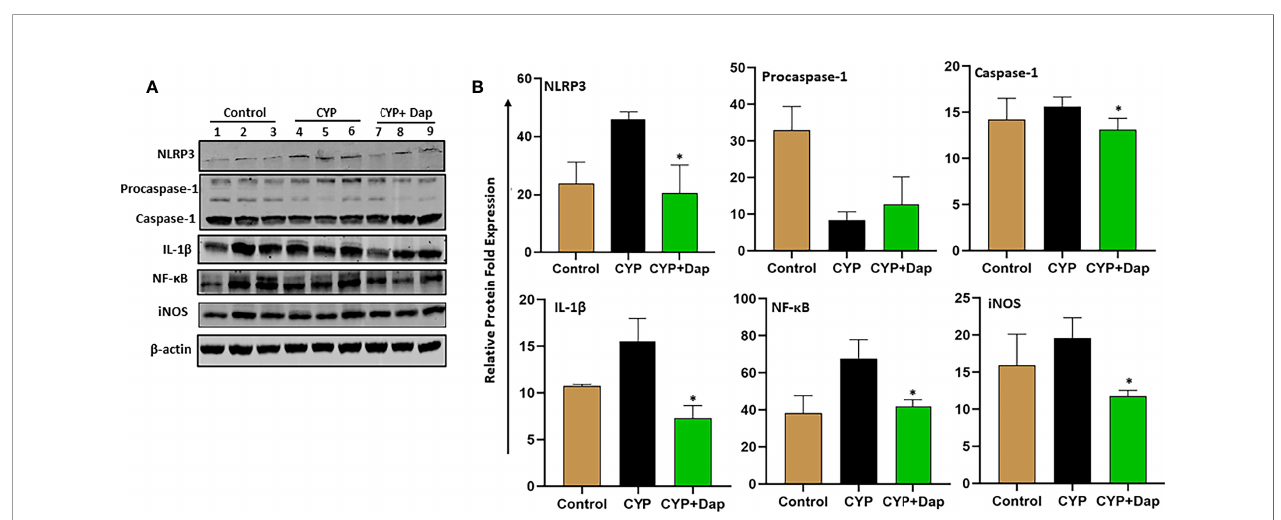
FIGURE 8 | Effect of Dap on NF-kB, NLRP3, iNOS, caspase-1, IL-1b expression during IC. Single UBs cell suspensions were obtained from the three groups at the experimental endpoint, as described in the legend in Figure 1 . Mean values ± SEM from three independent experiments involving six mice per group (n=18) are shown. (A) Cells were lysed, their protein concentrations were determined, and proteins were subjected to immunoblot analysis using antibodies speci fi c for NLRP3, NFkB, iNOS, caspase-1, and IL-1b. (B) The statistical signi fi cance of immunoblot data between the control (1-3), CYP+ vehicle (4-6), and CYP+ Dap (7-9) groups was assessed as a change in expression of protein as compared to control (normalized with actin). Asterisks indicate statistically signi fi cant differences between CYP+ vehicle and CYP+ Dap treated groups (*p <